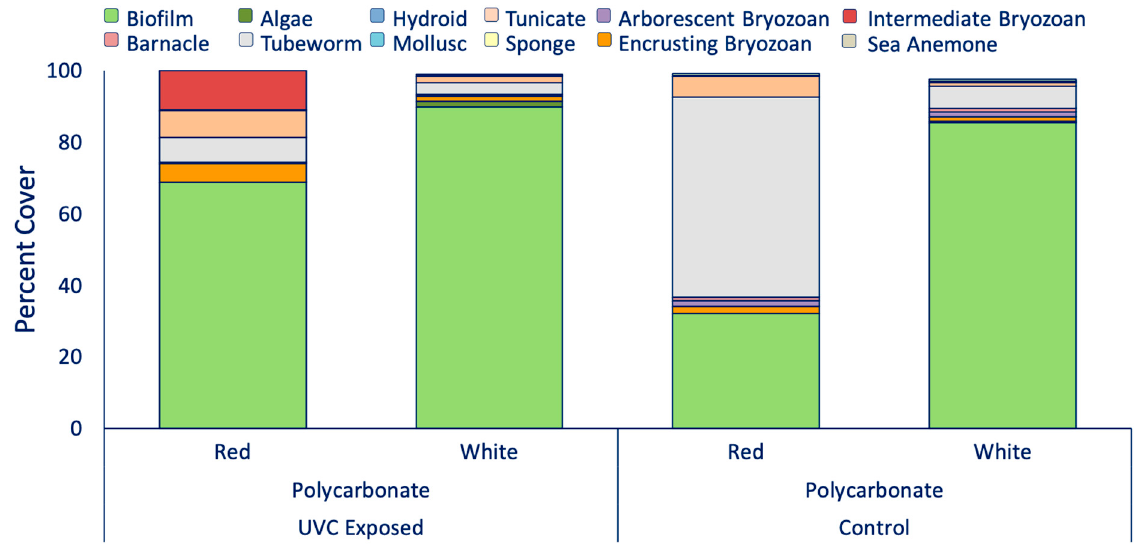
Figure 2. Biofouling composition on the UVC exposed red and white panels and their corresponding controls.